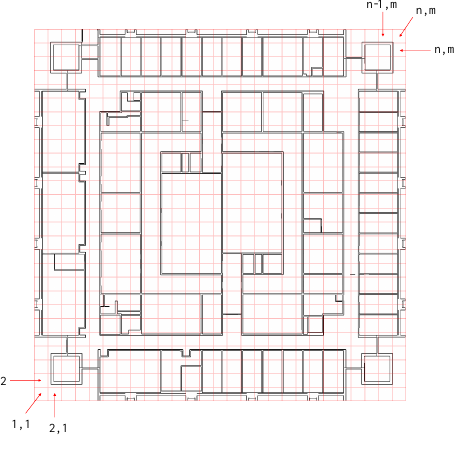
Figure 5. 2 × 2 m grid generated on the floor